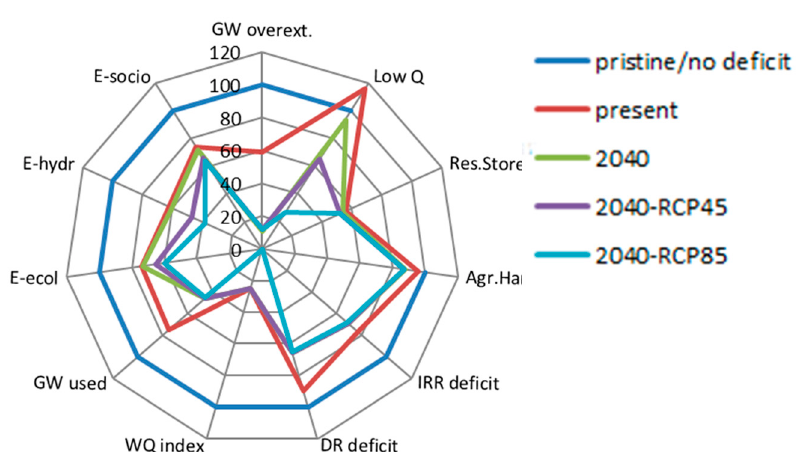
Table 6. Basin wide indicator scores for eight strategies under the IPCC 2040_RCP4.5 scenario.